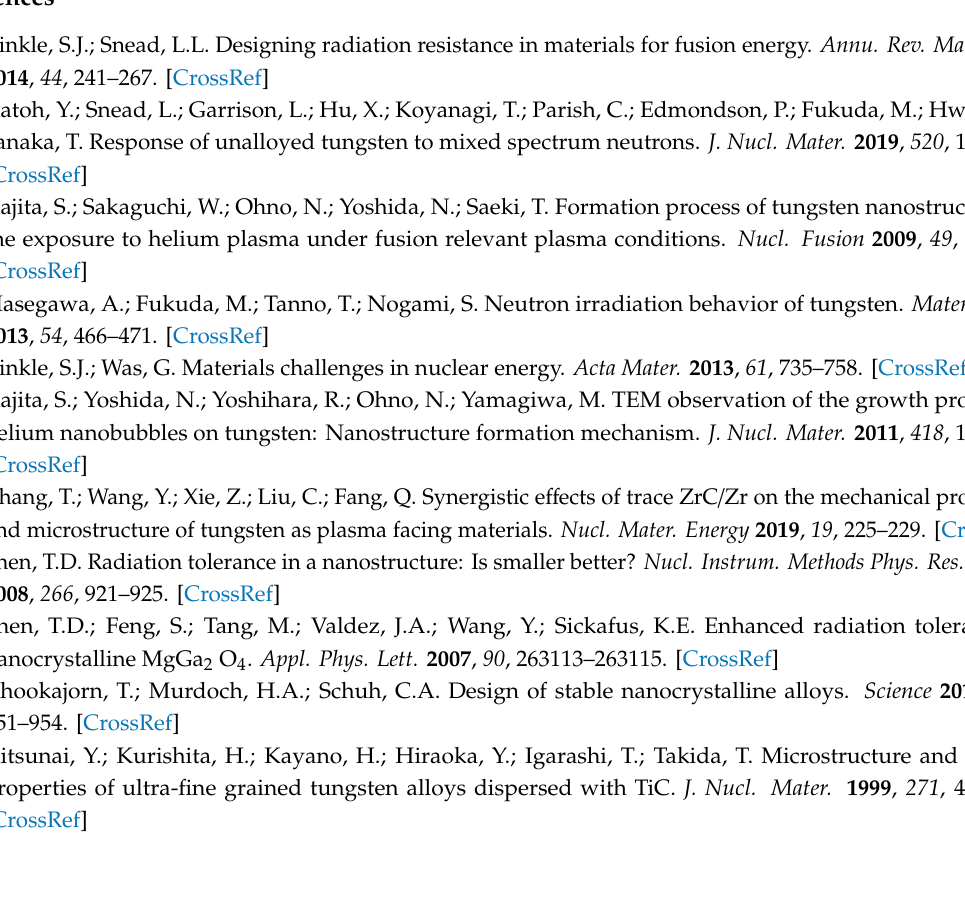
Figure S1: (Color online) Helium bubble density, average size, and total change in volume in the grain matrices of NCW and W-TiC as functions of He + fluence. (a) shows the original and the adjustment